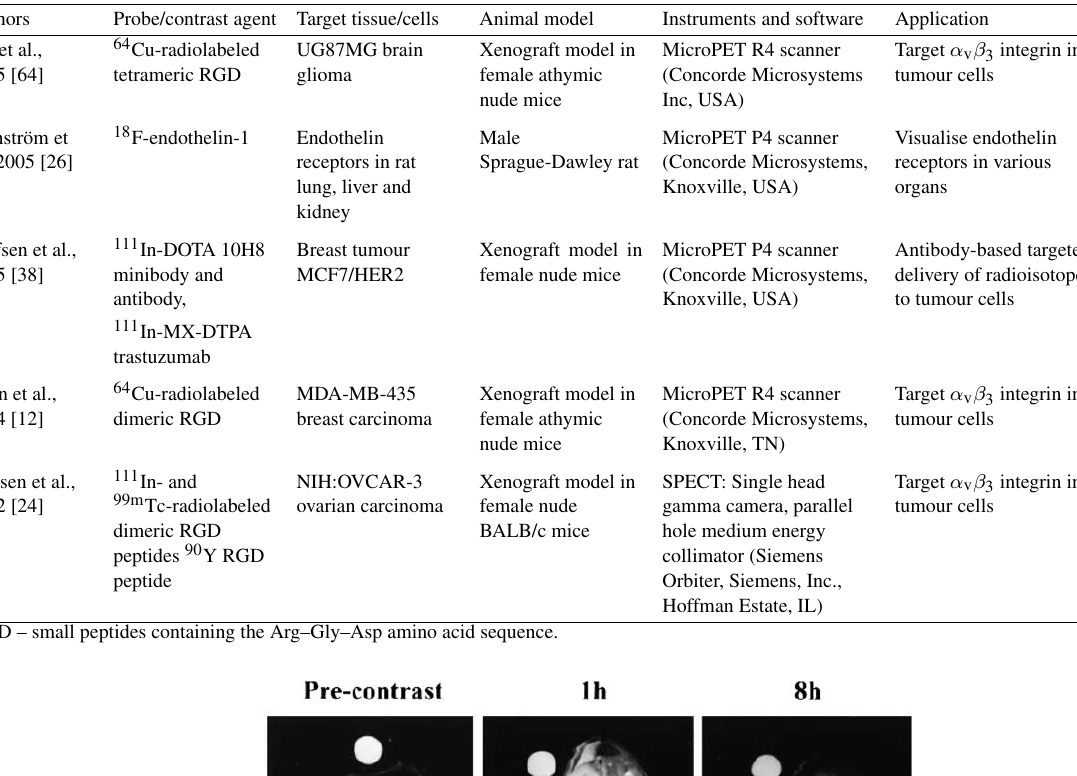
Summary of PET and SPECT application and instrumentation